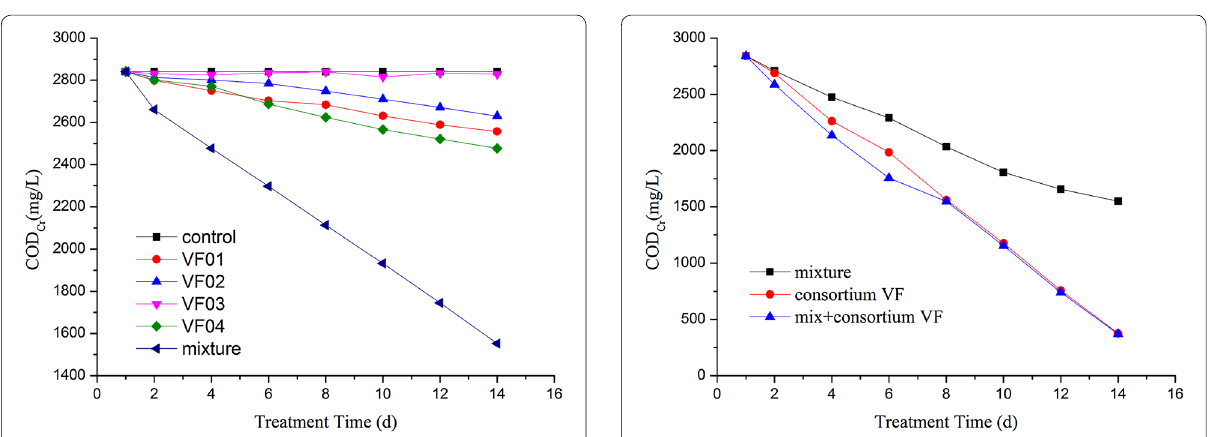
Fig. 4 Biodegradation of COD Cr by individual isolates, mixture of the four isolates, and the consortium VF